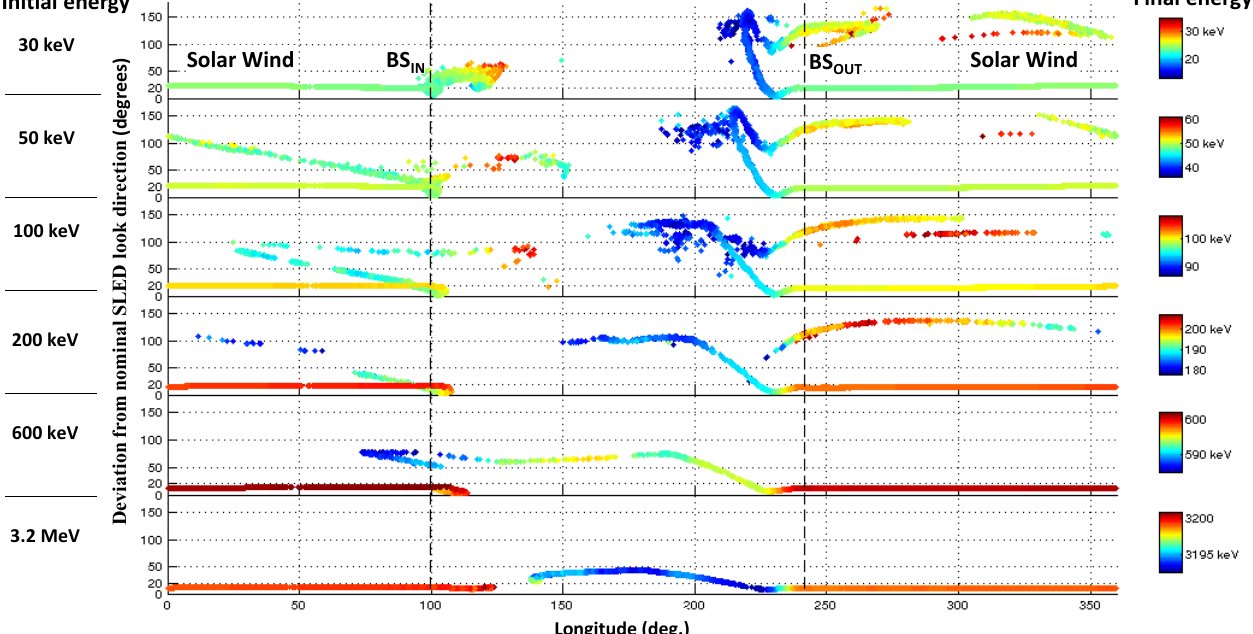
Fig. 7. Modelled scattering of high energy solar wind ions in the Martian magnetosphere. The six panels show the energies of the studied energetic protons whose initial energies were (from top to bottom) 30keV, 50keV, 100keV, 200keV, 600keV and 3.2MeV. A dot corresponds to a proton collected near the Phobos-2 circular orbit (within a 100km radius) on 13 March 1989. The vertical axis shows the angle β which is the angle between the ion velocity vector and the nominal SLED look direction. The colour of the dot gives the energy of the ion. Note that all the panels have their own colour scale which is shown on the right side of the panels. The horizontal axis shows the longitude of the position of the Phobos-2 spacecraft, and the angle is measured from the positive x-axis on the Martian orbital plane, with positive values toward the positive y-axis. Therefore, Phobos-2 was at the subsolar point at longitude 0 ◦ and in the middle of the magnetotail at longitude 180 ◦ . BS IN took place at longitude ∼ 100 ◦ and BS OUT at longitude ∼ 240 ◦